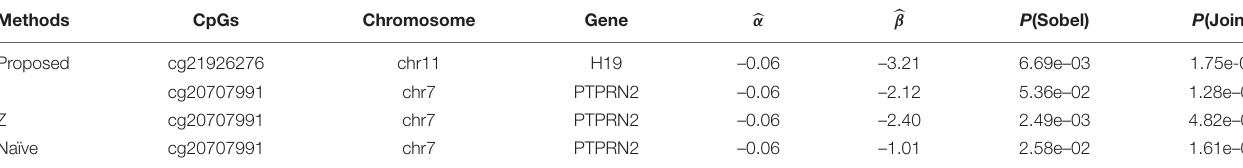
TABLE 4 | Summary of selected CpGs with estimators ( b α b β > 0) and P -values for significant